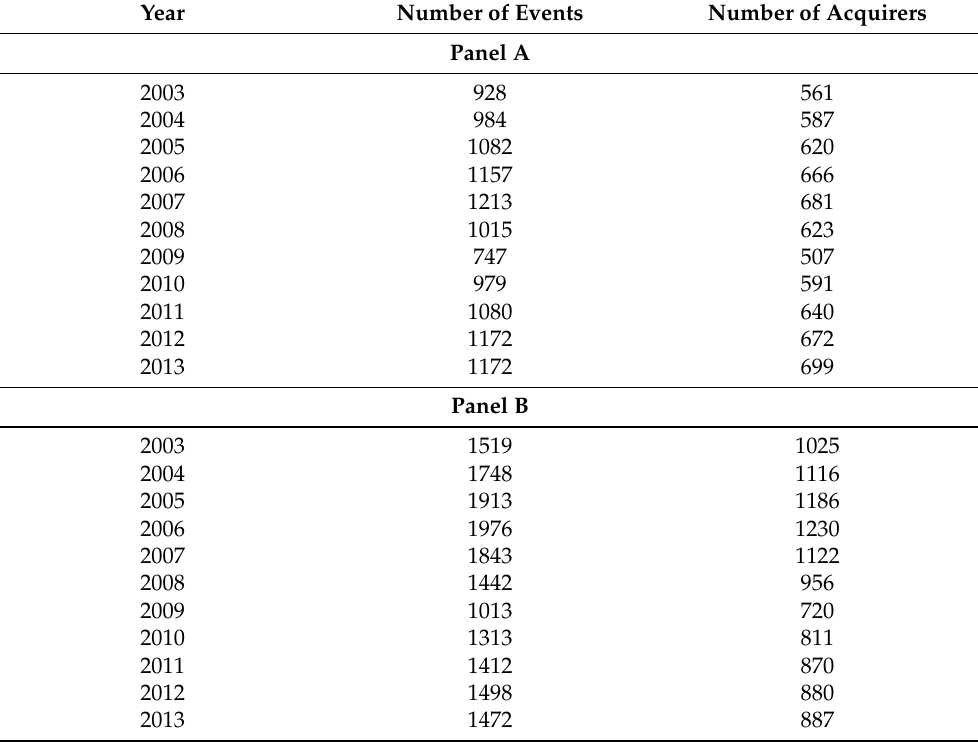
Table 1. M&A Over